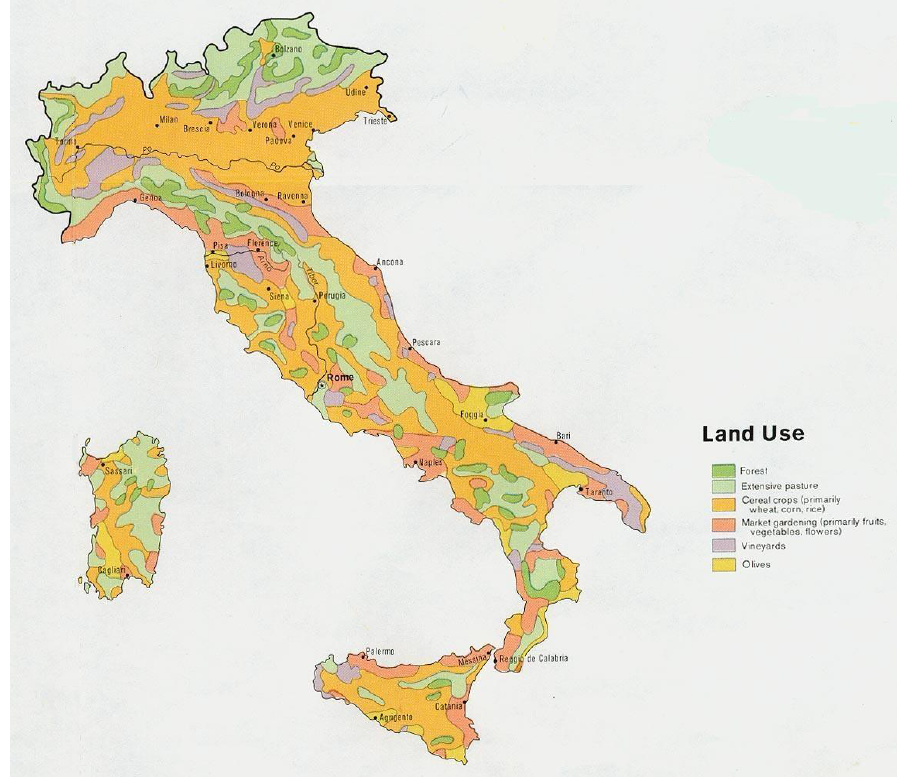
Figure 3. Map of Geographic Distribution of Types of Crops in Italy